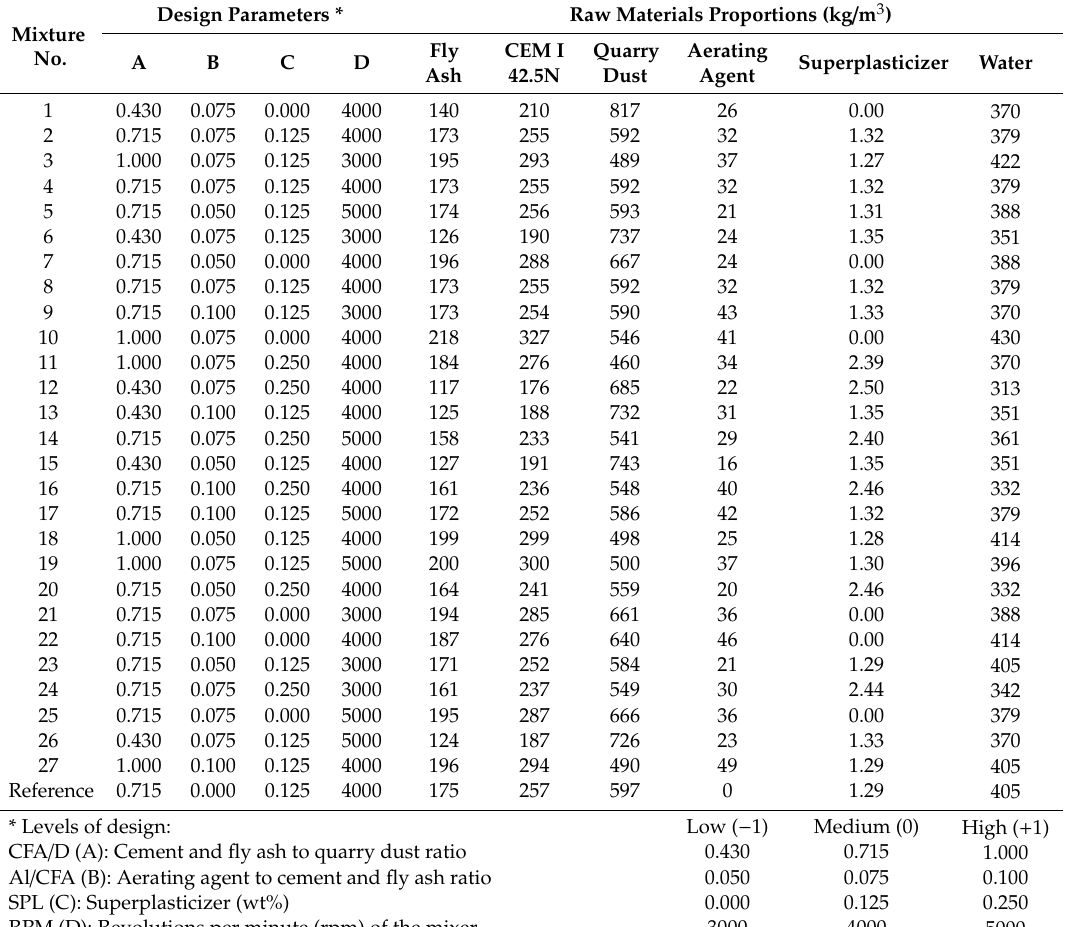
Table 2. Parameters and levels of design, mixtures prepared according to Box–Behnken factorial design, and raw material